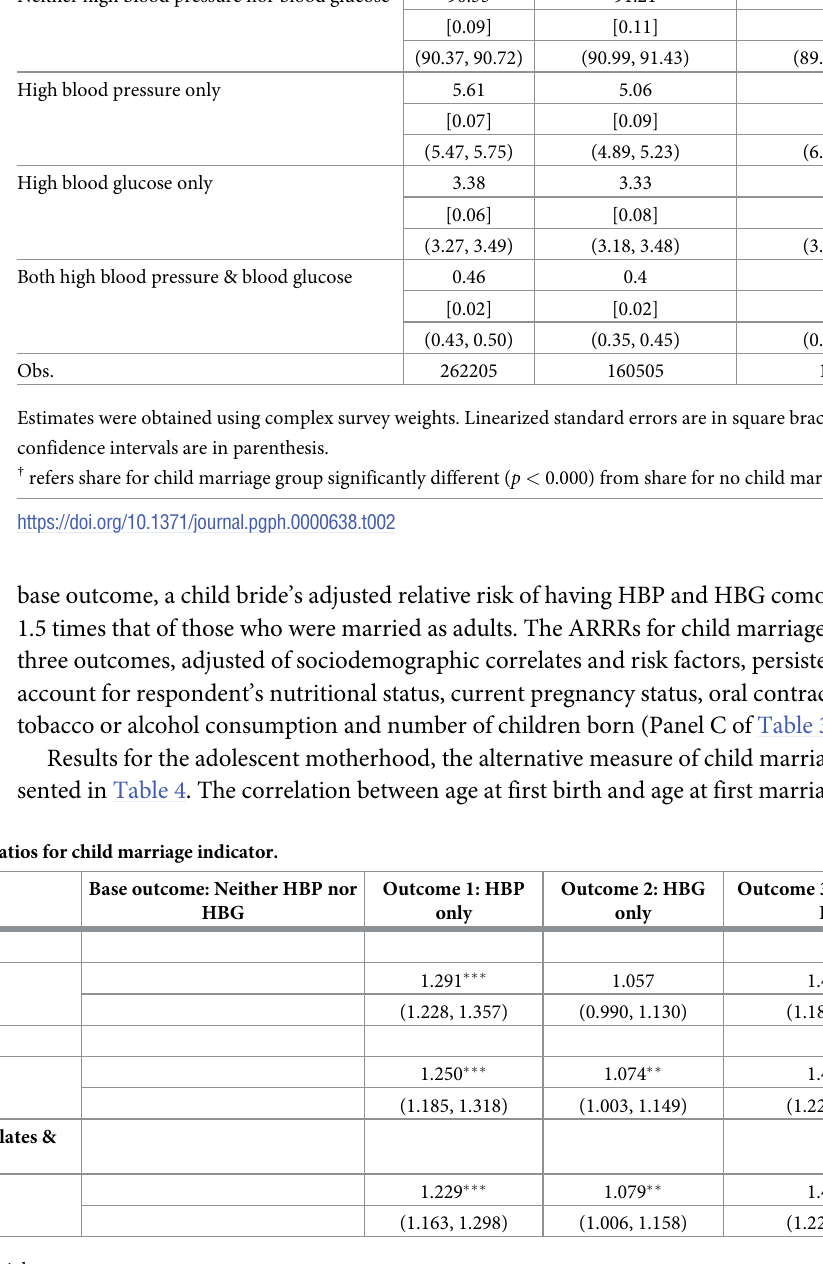
Table 2. Share of young adult women having blood pressure and blood glucose conditions by child marriage. All (%) Married as adults (%) Married as children (%)